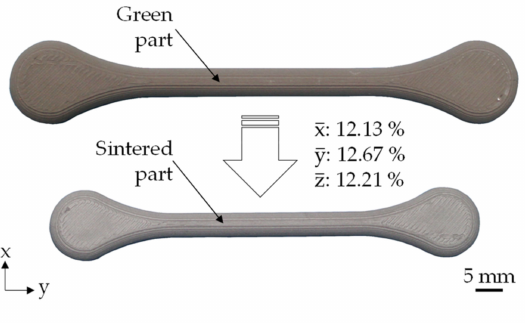
Figure 14. Average shrinkage of the PEX printed tensile specimens due to sintering; shown here is the flat